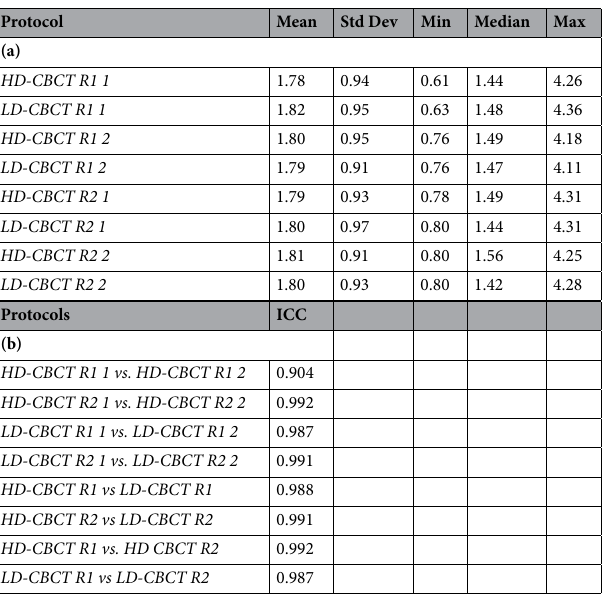
Table 1. (a) Means and medians of linear furcation measurements (f); (b) ICC-values of linear furcation measurements (f). Std Dev standard deviation, Min minimum, Max maximum, R1 rater 1, R2 rater 2, 1 first measurement, 2 s measurement.